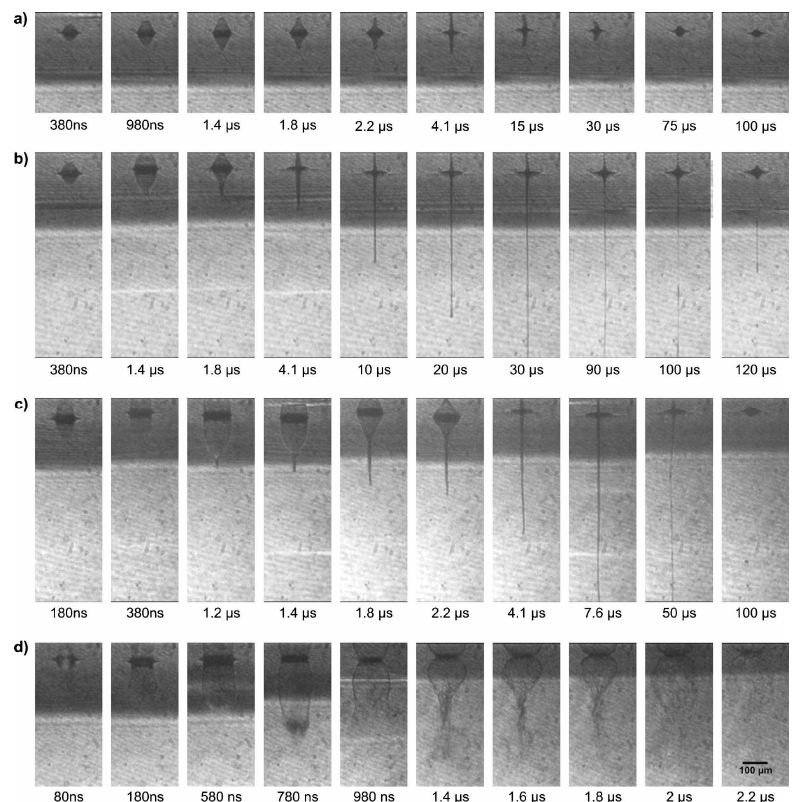
Figure 2. Images of a time resolved study of liquid ejection in LIFT at different laser fluences ( a ) 1.2, ( b ) 2.4, ( c ) 5.6, and ( d ) 10 J / cm 2 . The delay time with respect the laser pulse is indicated on top of each image. The laser beam impinges the donor layer from the top of the image. Reprinted from [37] with permission of AIP Publishing. When the laser fluence is just below the threshold for getting transfer jets can also be formed, but impulsion is not enough to reach the receiving substrate and they recoil with bubble collapse (Figure 2a). On the contrary, when the laser fluence is too high, the bubble explodes as the pressure inside the bubble exceeds surface tension forces leading to the ejection of material in the form of a burst or plume (Figure 2d) [37,47]. The viscosity of the ink plays a key role in the formation and stability of the jet [54]. Stable jets are much easily produced in a wider range of fluences as viscosity